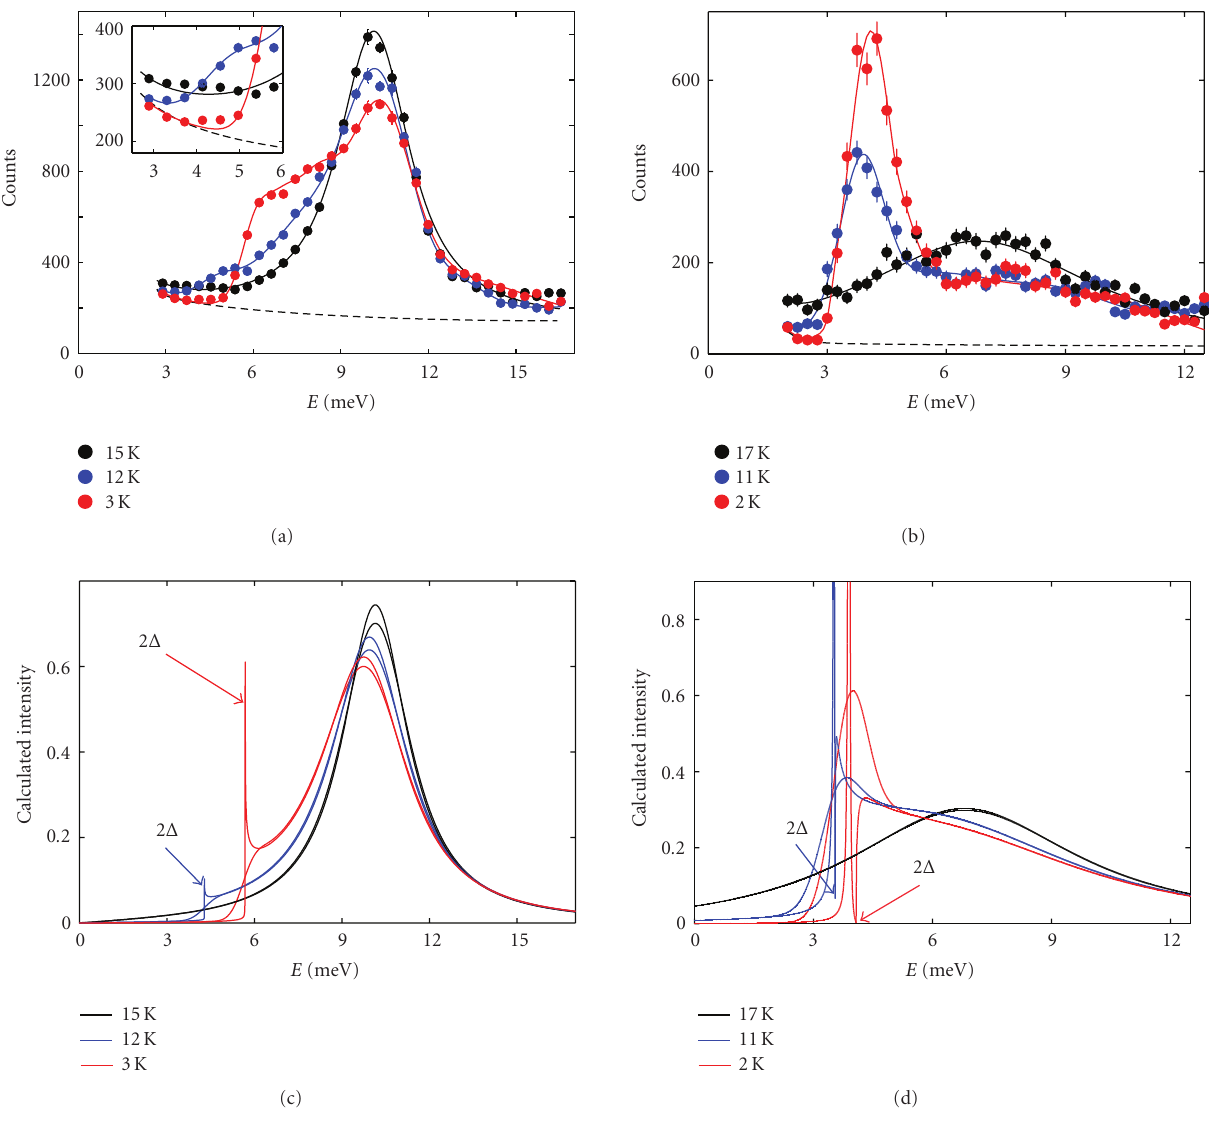
Figure 5: (a, b): Evolution of the neutron-scattering profile measured on YNi 2 B 2 C at Q = (0 . 5,0 . 5,7) (left) and Q = (0 . 5,0,8) (right) above and below T c = 15 K. (c, d): Thin lines represent calculated phonon lineshapes based on the theory of Allen et al. [19], using parameters extracted from the line-shape observed in the normal state. The thick lines are obtained after the convolution with the experimental resolution (from